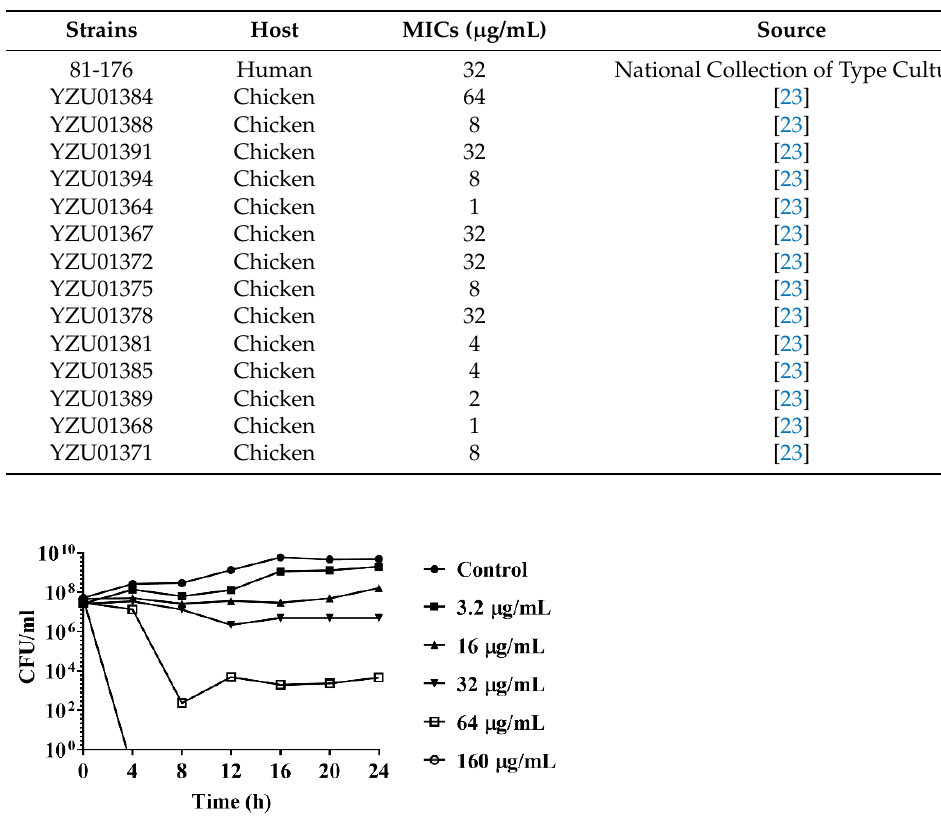
Figure 1. Time-kill curve of C. jejuni strain 81-176 with DATS. The treatment concentration of DATS included 3.2 μ g/mL, 16 μ g/mL, 32 μ g/mL, 64 μ g/mL and 160 μ g/mL. 2% of dimethyl sulfoxide without DATS were used as a negative control. The data represented the means ± standard deviation.